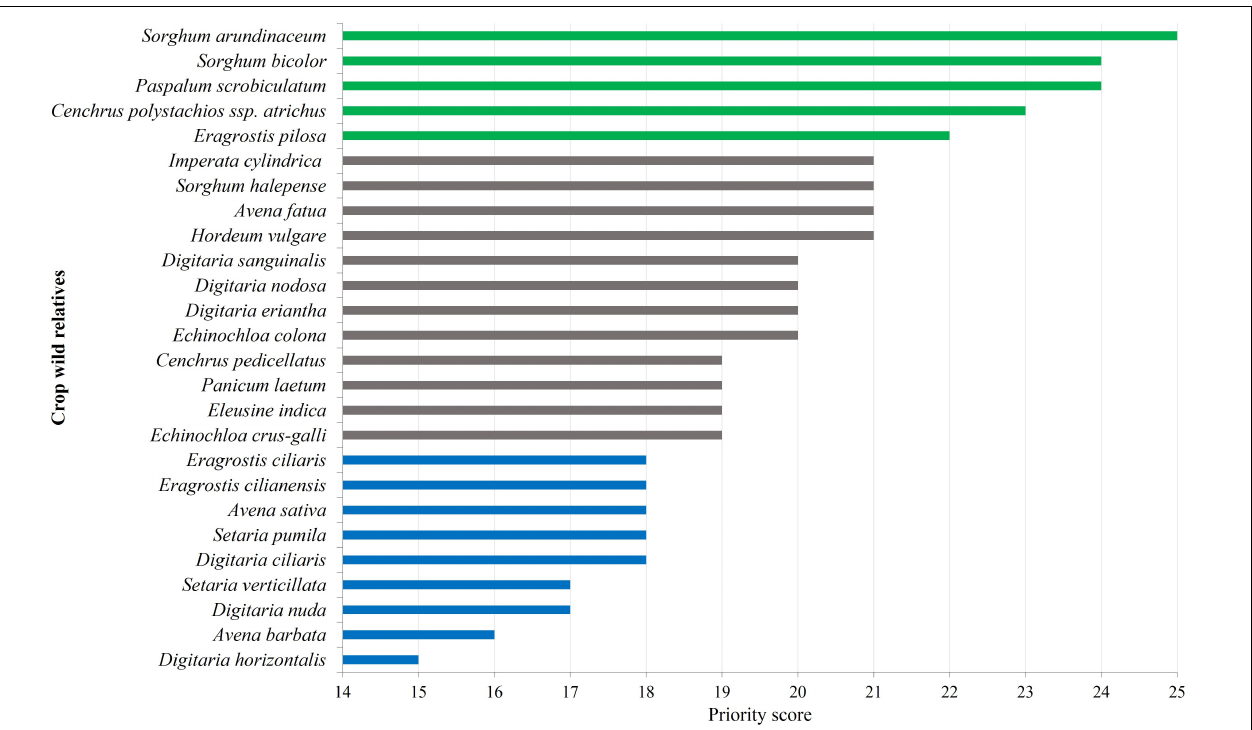
FIGURE 3 | Priority for collecting and conserving the CWR Poaceae. Different colors represent different priority categories: green – highest (PS > 21), gray – medium (21 ≥ PS > 18), and blue – low (PS ≤